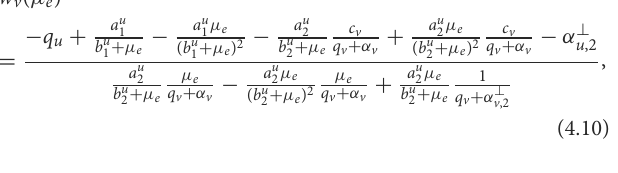
FIGURE5 3-D Bifurcation diagram, computed from Equation (4.4), for symmetric and asymmetric steady-states of a two-cell ring pattern with ring radius r and two different values of d u with GM kinetics (4.3). Left: d u 0.08. Right: d u 0.05. For these values of d u , the steady-states exhibit hysteresis, i.e., a = = subcritical pitchfork bifurcation occurs from the symmetric equilibrium branch, with the emerging unstable asymmetric equilibrium branches regaining stability at a secondary fold point. Observe that the extent of the hysteresis increases when d u decreases. Parameters: D u D v 5, σ u 0.6, ε 0.03, and r 0.5. σ v = = = = = =